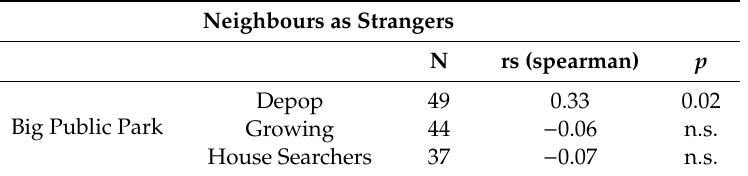
Table 4. Significance and correlation coe ffi cients rs between the levels “big public park” and “neighbours as strangers”, according to the subgroups: “depopulating neighbourhoods”, “growing neighbourhoods”, and “house searchers”.